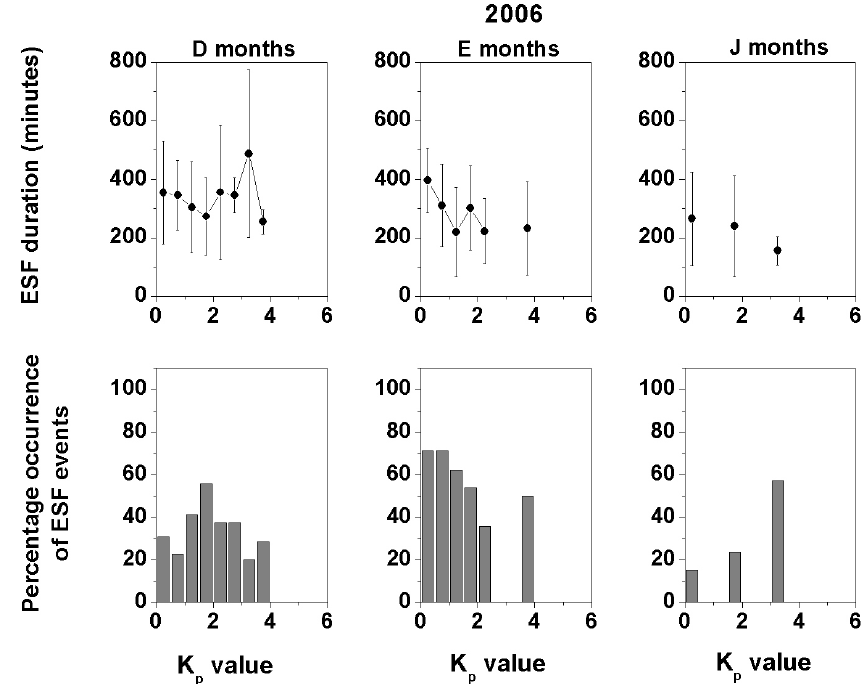
Fig. 4b. Same as for Fig. 4a, but for the solar minimum year of